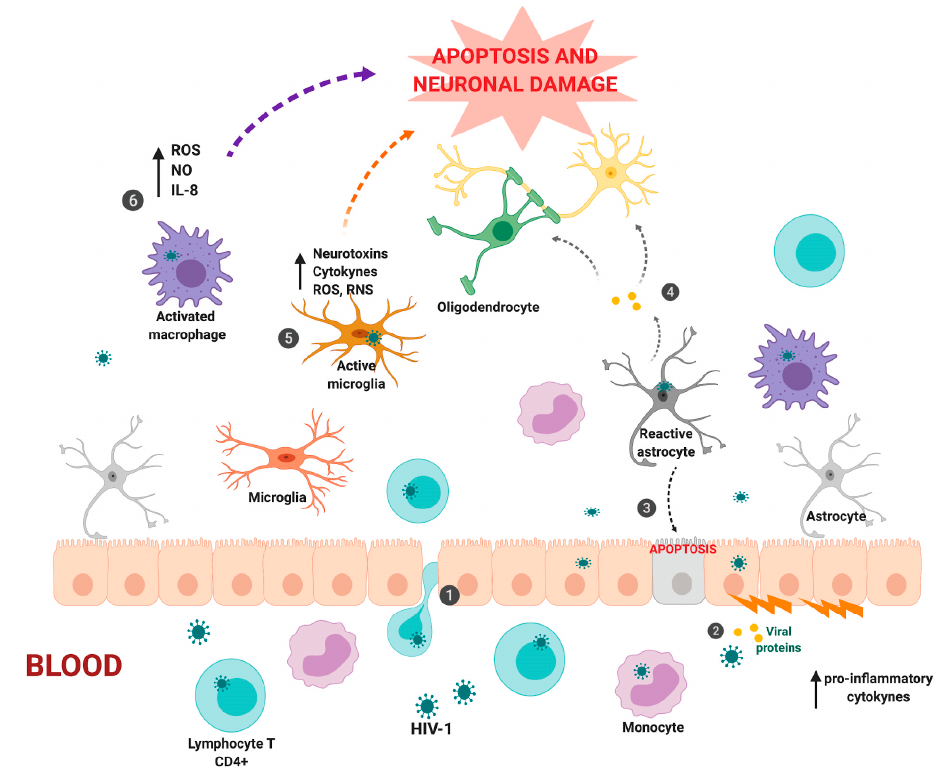
Figure 1. Entry of human immunodeficiency virus (HIV)-1 into the central nervous system and its effects on cells that lead to damage and death of neurons. ( 1 ) HIV-1 can enter through monocytes or infected T cells that migrate from the bloodstream to the central nervous system (CNS) (Trojan horse theory). ( 2 ) The increase in pro-inflammatory cytokines and viral proteins can alter the permeability of the epithelial cells of the blood–brain barrier, making virus entry easier. In addition, the virus can use infected epithelial cells and reach the other side through transcytosis. ( 3 ) Reactive astrocytes can induce epithelial cell apoptosis, contributing to the modification of the permeability of the blood–brain barrier through the release of viral proteins such as Tat. ( 4 ) The viral protein Tat has a direct effect on oligodendrocytes and neurons, which produce increased damage and neuronal death. Chronic activation of activated ( 5 ) microglia and ( 6 ) macrophages generates an increase in the levels of proinflammatory cytokines, neurotoxins, reactive oxygen species (ROS), and reactive nitrogen species (RNS) (created with BioRender).